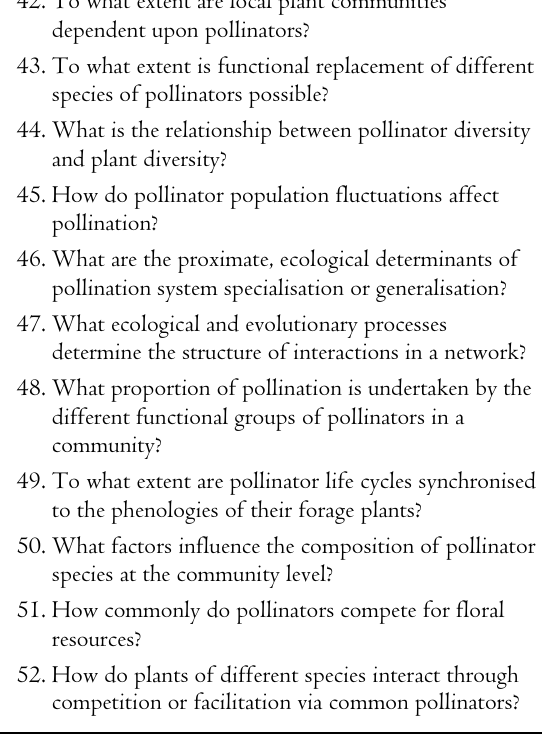
Box 8: Questions on plant-pollinator